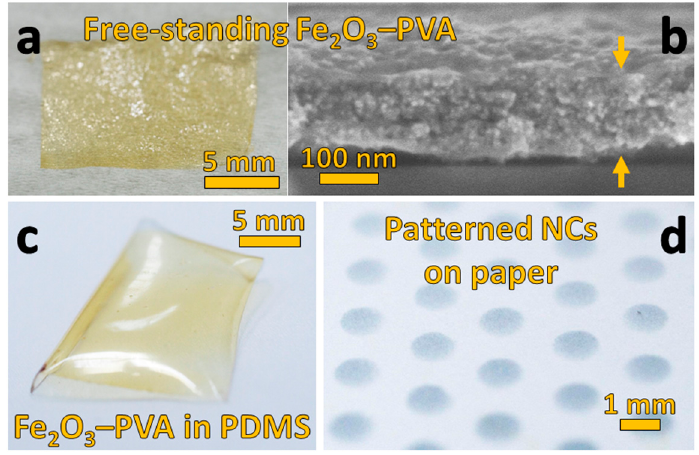
Figure 4. ( a ) Free-standing γ -Fe 2 O 3 –PVA film (t = 3 min; C p = 1/32 wt %) after removal from the sacrificial layer-coated substrate (now on Kimtech ® tissue). The cross-section of this film ( b ) depicts the high homogeneity, large filler fraction and its <200 nm thickness. This same film was also prepared directly onto untreated PDMS. After additionally coating it with a transparent PDMS layer, this mechanically robust nanocomposite ( c ) is made free-standing. ( d ) Standard white printer paper (80 g · m − 2 ) was used as substrate for circular TiO 2 –PEDOT:PSS nanocomposite (NC) array deposition (t = 1 min) through a shadow